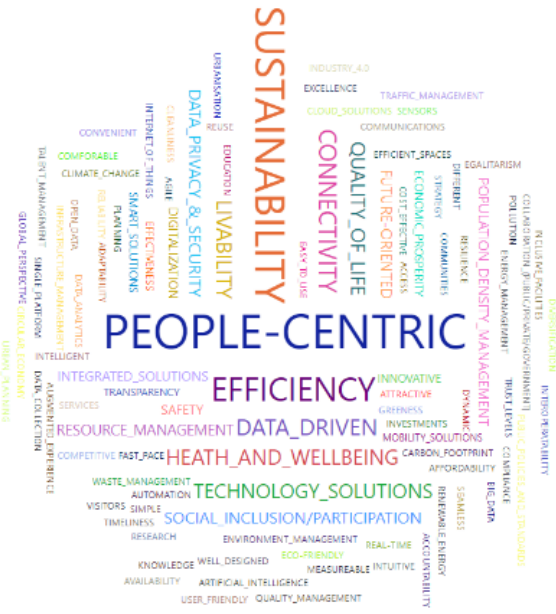
Figure 5 . Smart City Characteristics